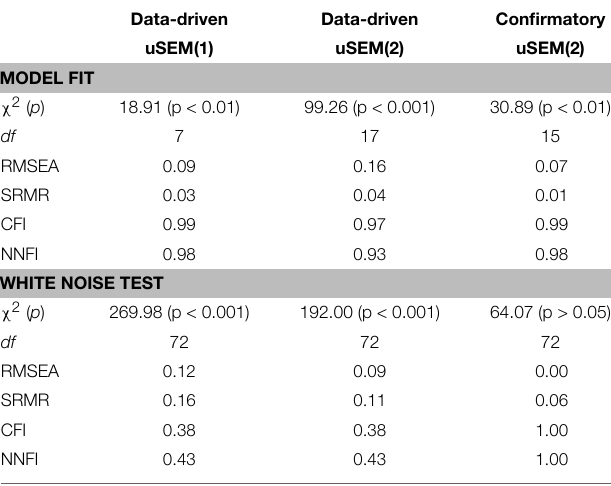
TABLE 1 | Model fit indices and white noise test results for the series of uSEM models fit to the single-subject simulated data